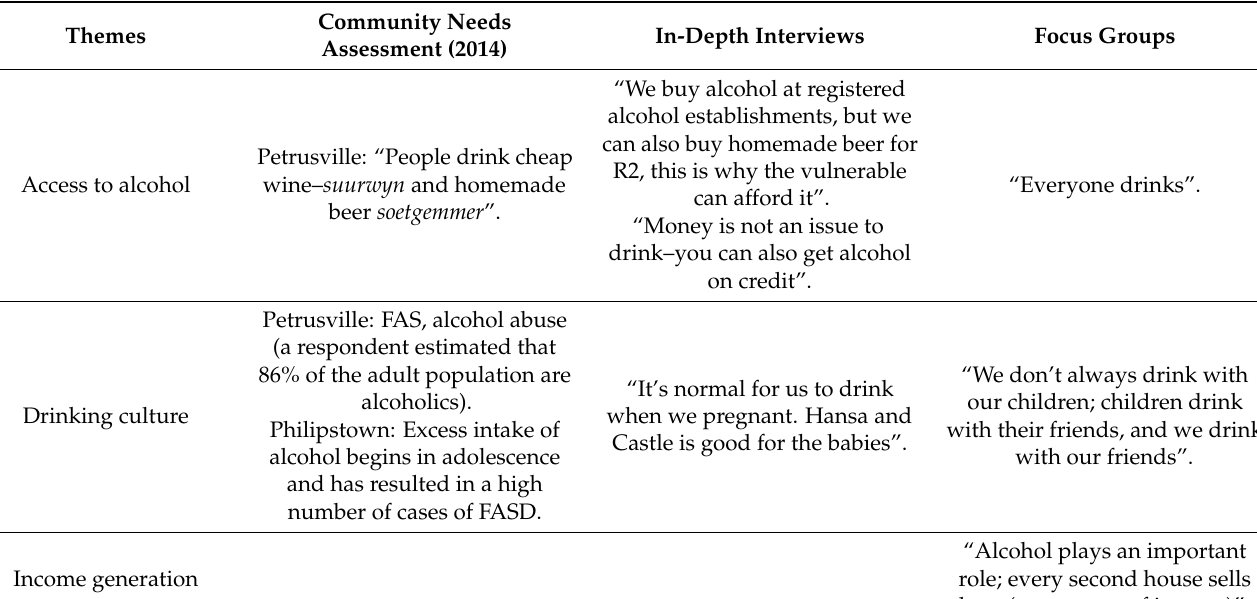
Table 8. The results of data sources 1, 3, 4, and 7 provide insights into the drinking culture in